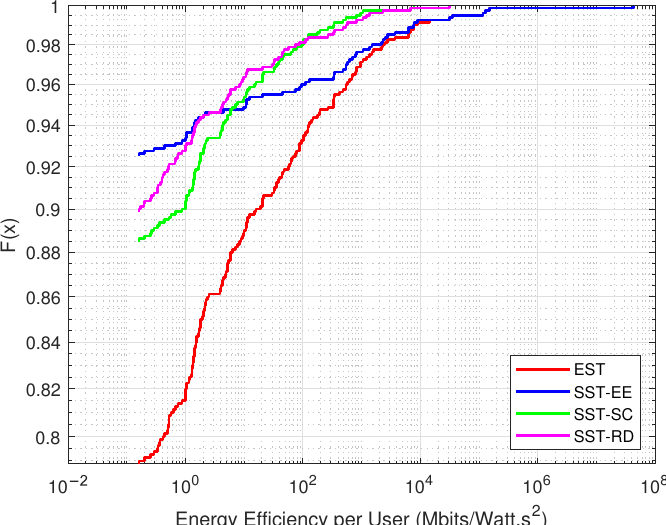
Figure 8. Variation in the distribution of the energy efficiency in the